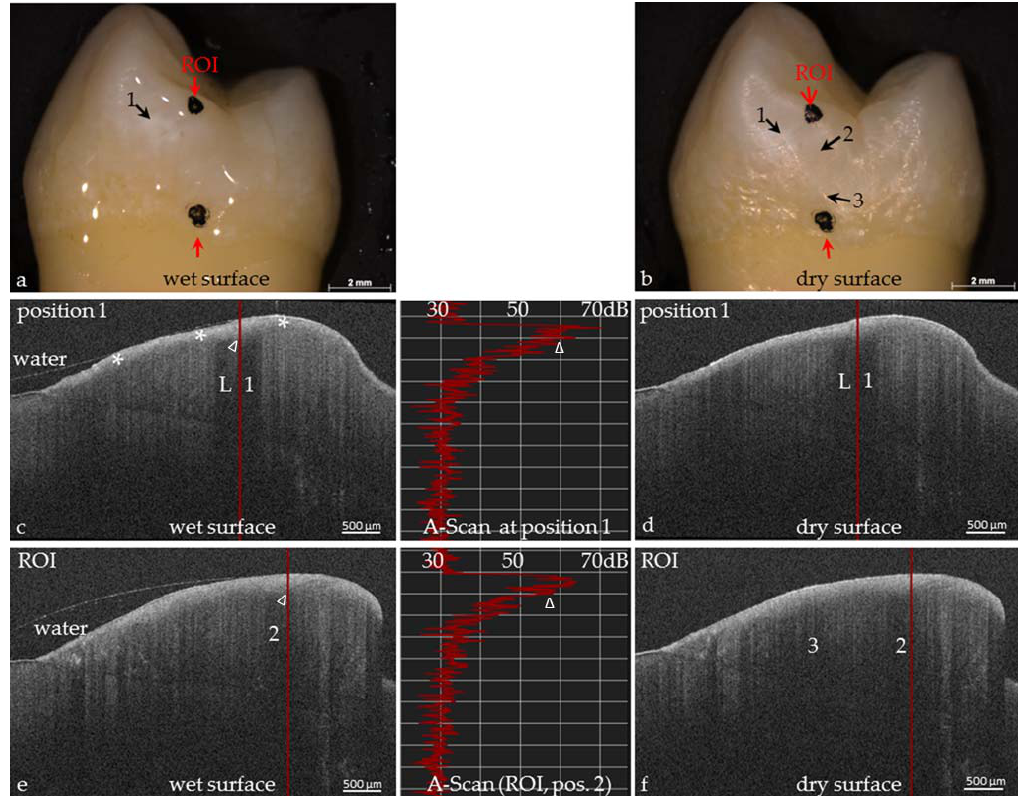
Figure 11. Extracted human premolar with early proximal demineralizations. There is a partial match of the visual and OCT assessment. ( a ) Hardly visible on wet enamel, the early demineralization (1) could also be seen on the dry surface ( b ); ( c – f ) SD ‐ OCT reveals a clinically invisible demineralization in the outer enamel zone (*); ( c , d ) The OCT images reveal a bright signal in position 1 (L, shadow); ( e ) The OCT of the wet surface shows an early demineralization in position 2 of image ( b ); ( f ) After air drying, an additional signal arises in position 3. Visually both lesions are invisible ( a , b ). With the knowledge of the OCT images, at points 2 and 3, slight opacities could also be anticipated on the images ( a , b ). The A ‐ scans (average 5) of the marked positions 1 and 2 in the OCT ‐ images demonstrate the depth profiles of the demineralized zones of the enamel surface. Δ grey scales between demineralized and healthy region.